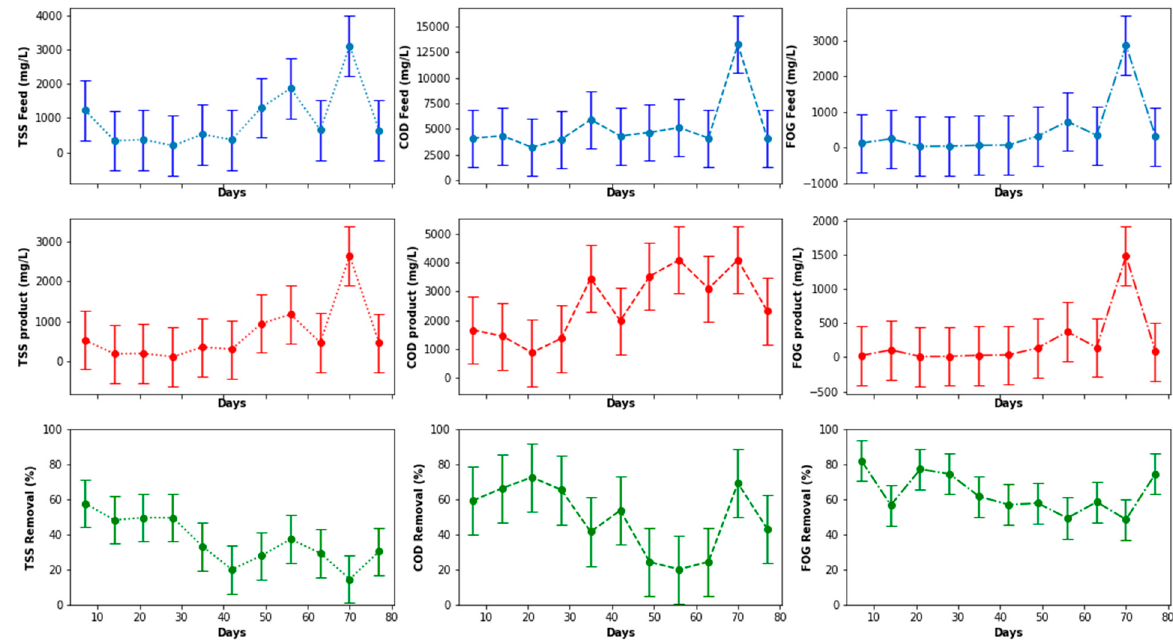
Figure 6. Pretreatment stage performance determined using COD, TSS, and FOG removal.